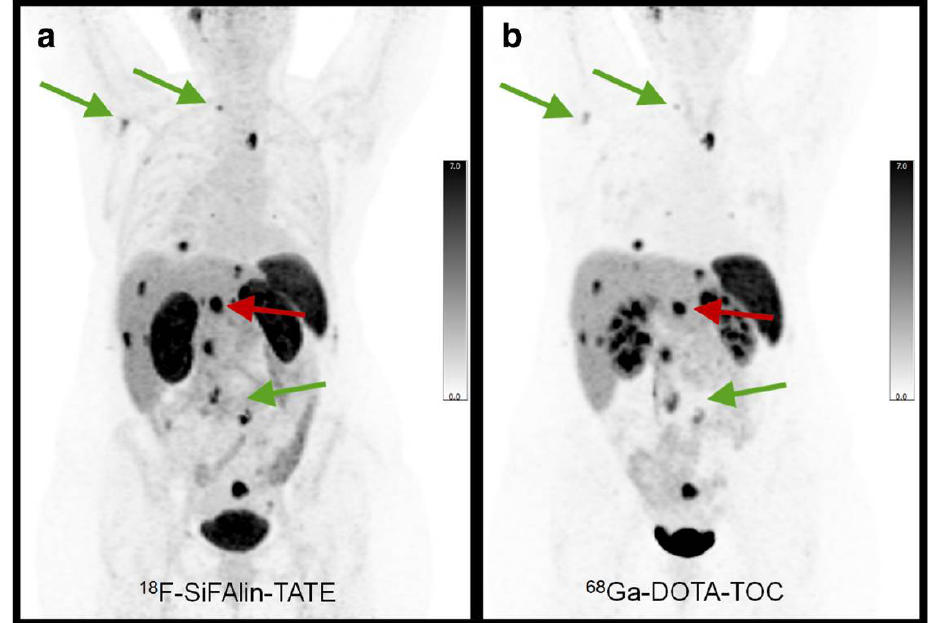
Figure 8. In-patient comparison of PET image quality between ( a ) [ 18 F]SiTATE and ( b ) [ 68 Ga]Ga- DOTA-TOC. Patient was a 39-year old female with Ileum NET. Comparison shows superior image quality with [ 18 F]SiTATE, especially for small lesions. Reprinted with permission from Ref. [38]. Copyright 2019 Springer Nature.